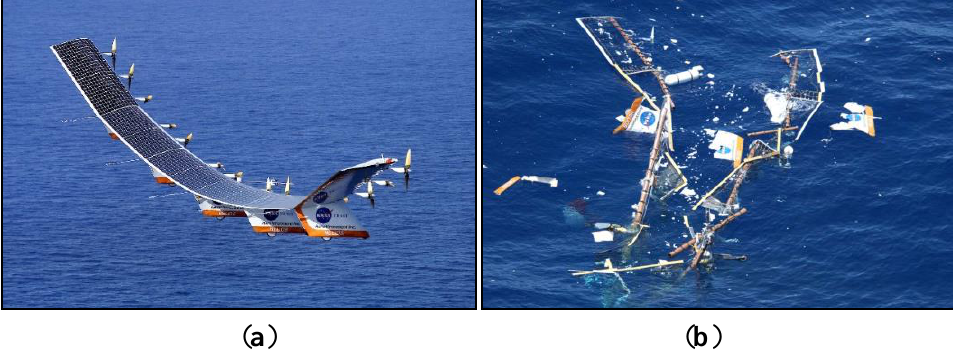
Figure 9. NASA’s Helios wing ( a ) and its wreckage in the Pacific ( b ) (courtesy of NASA).